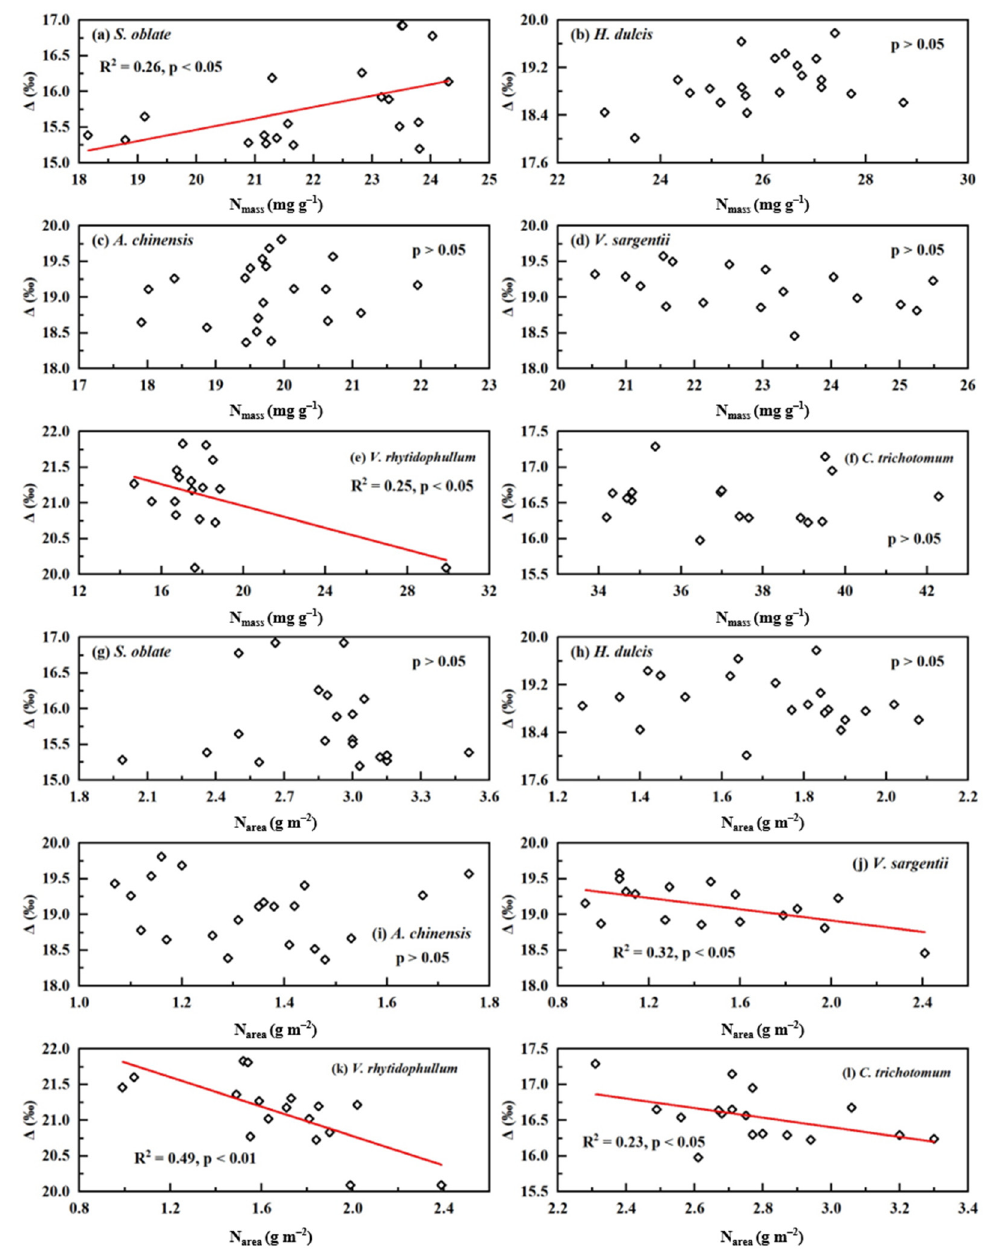
Figure 3. Relationships between leaf N and carbon isotopic discrimination ( ∆ ) at plant individual level for plants derived from the third sampling campaign: ( a – f ) N mass vs. ∆ ; and ( g – l ) N area vs. ∆